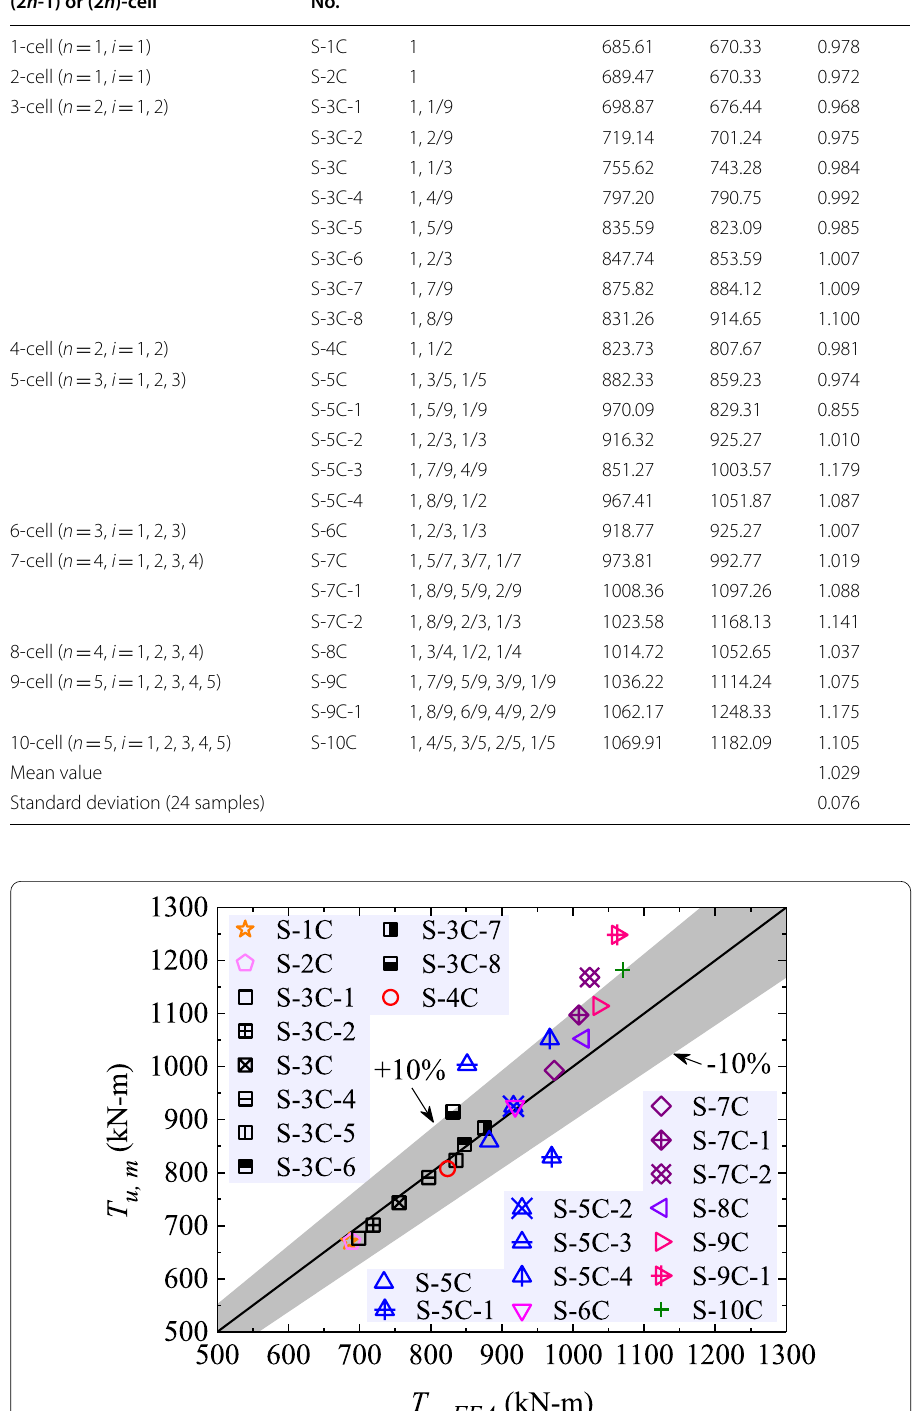
Table 4 Prediction accuracy of the USMMT on ultimate torques of various multi-cell BGCSWs BGCSWs R di T u , FEA T u , m T u , m / T u , FEA (2 n ‑1) or (2 n )‑cell